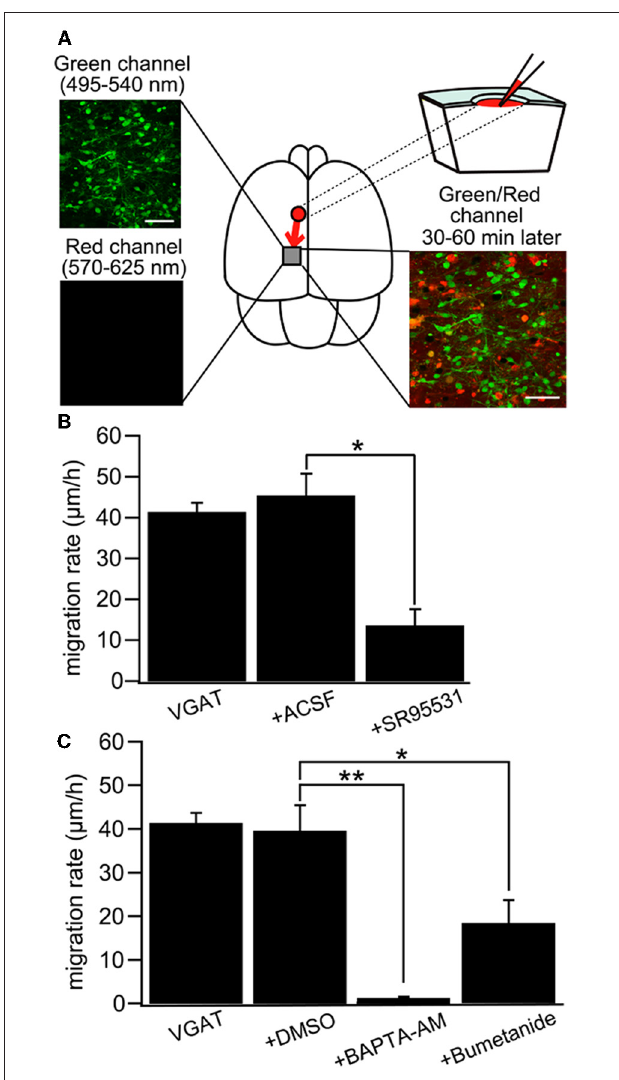
FIGURE 9 | GABA regulates tangential migration in the immature cortex in vivo . (A) Upper left: Two-photon image of Venus positive cells immediately after drug application in a P0VGAT-Venus mouse. Making a hole at 1–2mm away from the observed area has no effect on the morphology of the cells within imaging area. Scale bar = 50 μ m. Lower left: Two-photon image of sulforhodamine 101 (SR101) showing that the drug does not reach the imaging area immediately after injection. Upper right: Schematic drawing of the drug injection procedure; making a hole and injecting the drug conjugated with SR101. The drug diffuses into the imaging area after 30–60minutes of injection. Lower right: Two-photon image of Venus-positive cells and SR101 showing that the pipette solution spread around the cells without injuring them. Scale bar = 50 μ m. (B) Cell displacement during 1h of migration for neurons in VGAT-Venus without drug application (VGAT), after injection of ACSF ( + ACSF) and after injection of SR95531 ( + SR95531). The selective GABA A R antagonist (SR95531, 1mM, 1 μ l) reduced the migration rate significantly ( ∗ p < 0 . 05) whereas ACSF (1 μ l) had no effect. (C) DMSO (1 μ l) had no effect on cell displacement. Chelating intracellular Ca 2 + by BAPTA-AM (2mM, 1 μ l) conjugated with DMSO almost completely inhibited the migration ( ∗∗ p < 0 . 01) and blockade of NKCC by bumetanide (1mM, 1 μ l) significantly reduced the migration rate ( ∗ p < 0 . 05). [From Inada et al.